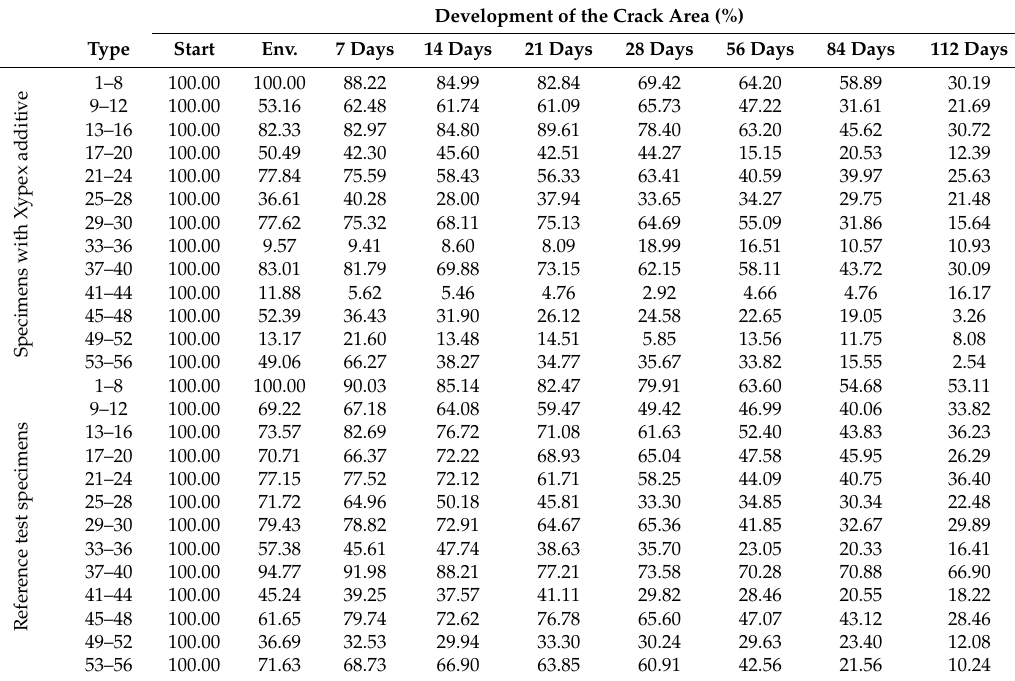
Figure 14. Crack development in reference specimens—the second phase (T = time of exposure). Table 9. Comparison of crack development—the second phase.